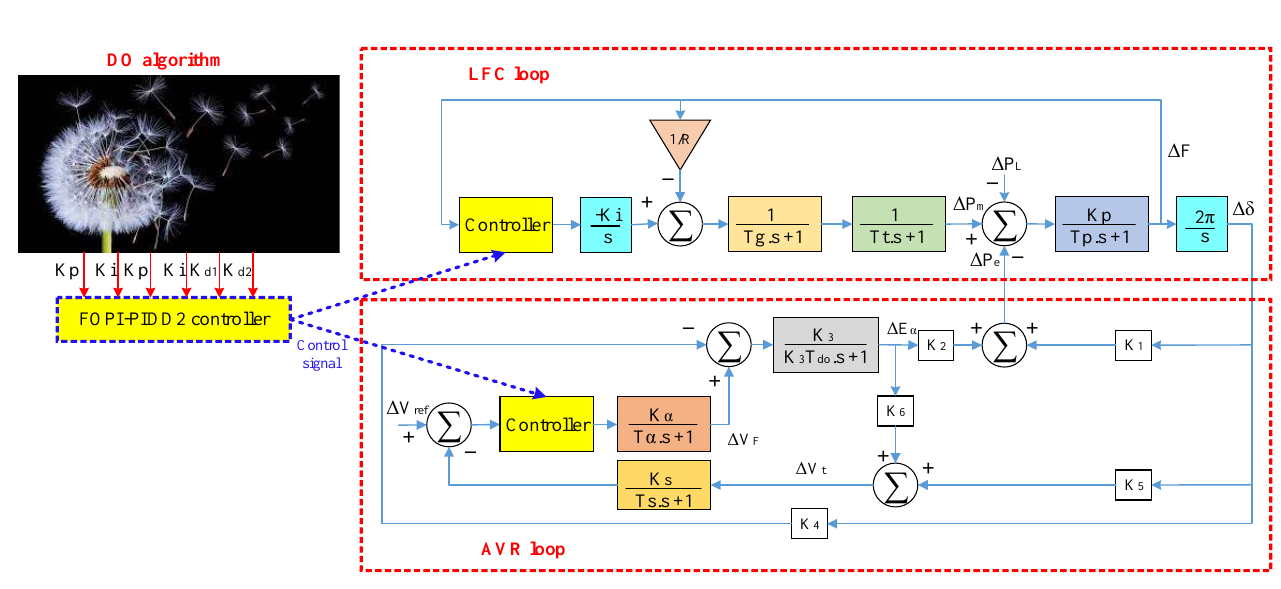
Figure 6. The combined LFC–AVR model with the proposed controller. The terminal voltage Vt consists of two components: the voltage V q on the q axis, which increases with the increase of E, and the voltage V d on the d axis, which increases with the increase of δ . This relationship is shown by Equation (28).